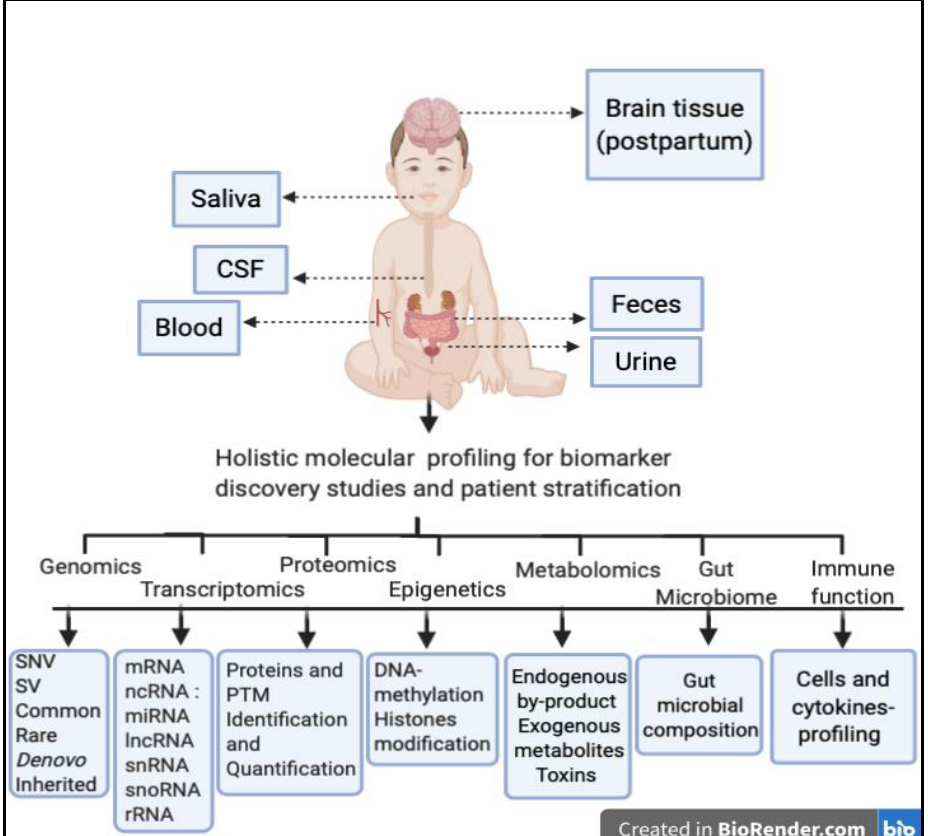
Figure 1. Schematic showing possible body fluids and tissues that may be essential for biomarker discovery in ASD patients. Blood is the most common site for biomarker discovery. However, saliva, urine, and feces are easily accessible and have been used recently for biomarker discovery studies. Although CSF and brain tissues could also be used for biomarker discovery in ASD, their accessibility is very difficult or even impossible (in the case of the brain, unless it is postpartum) for such purposes. Collecting huge biological data from a range of body fluids may help in performing holistic molecular profiling in the area of genomics, transcriptomics, proteomics, epigenetics, metabolomics, gut microbiome, and immune system, which may enhance biomarker discovery and patient stratification. Synucleins have also been studied in the context of ASD. Synucleins are a family of proteins that are abundantly expressed in the presynaptic terminals of the neocortex, cerebellum, thalamus, and striatum [74]. The synuclein family includes α , β , and γ - synucleins (syn). Of a particular interest, the function of α -syn is not well understood. However, α -syn is thought to be involved in vesicle stabilization, synaptic plasticity, and regulates dopamine release [75,76]. α -syn is known to be involved in